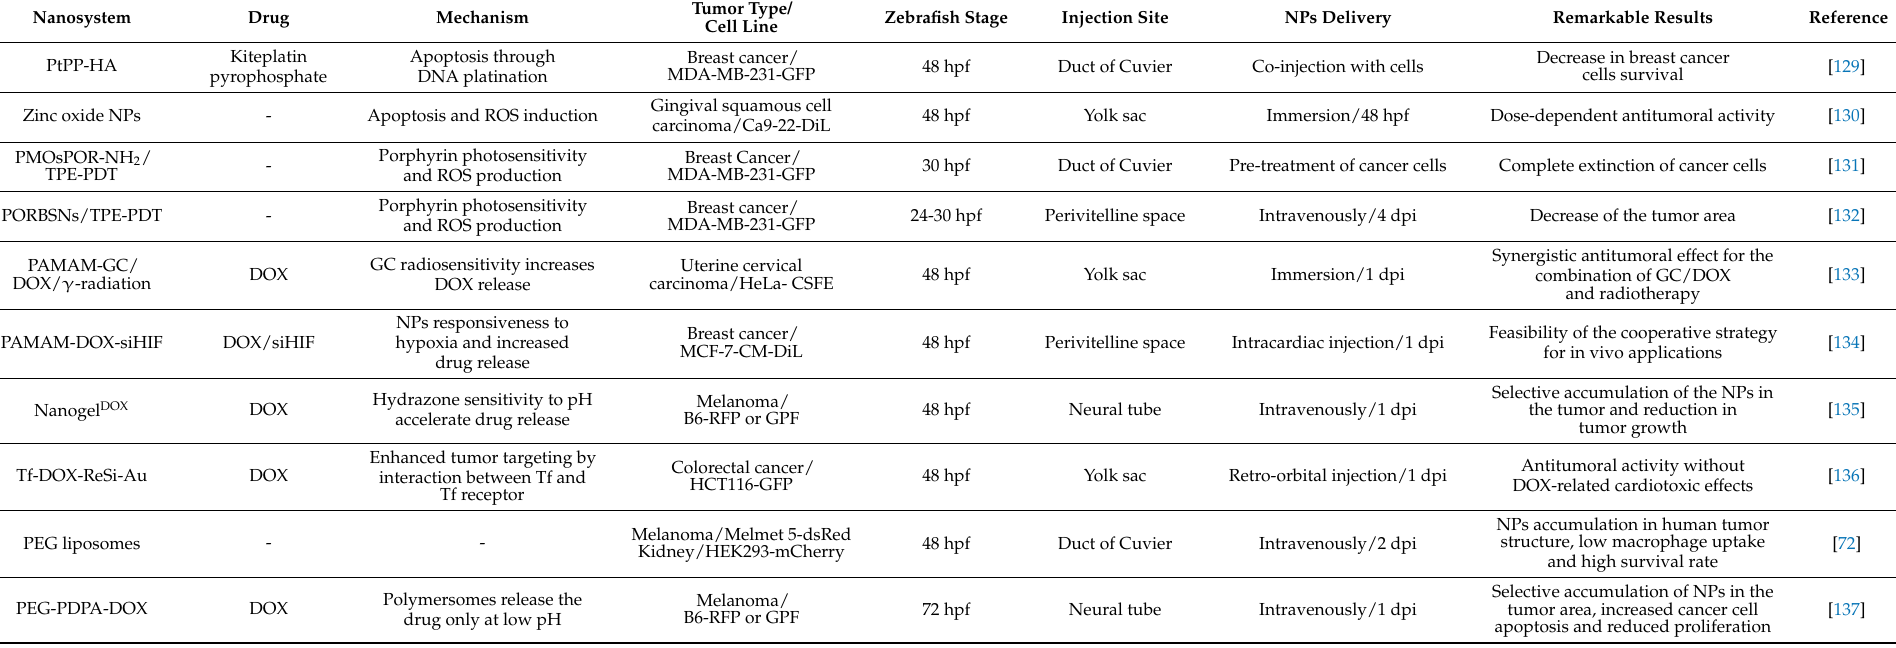
Table 1. Evaluation of nanoparticle-based approaches for cancer treatment using xenograft zebrafish